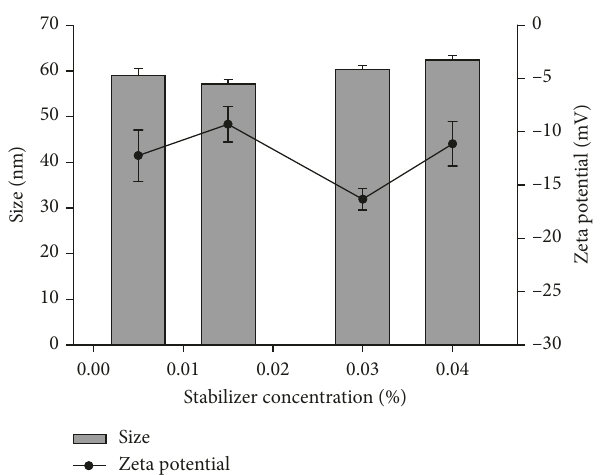
Figure 2: Effect of stirring time on the size and zeta potential of Cur-TPGS-PMs.